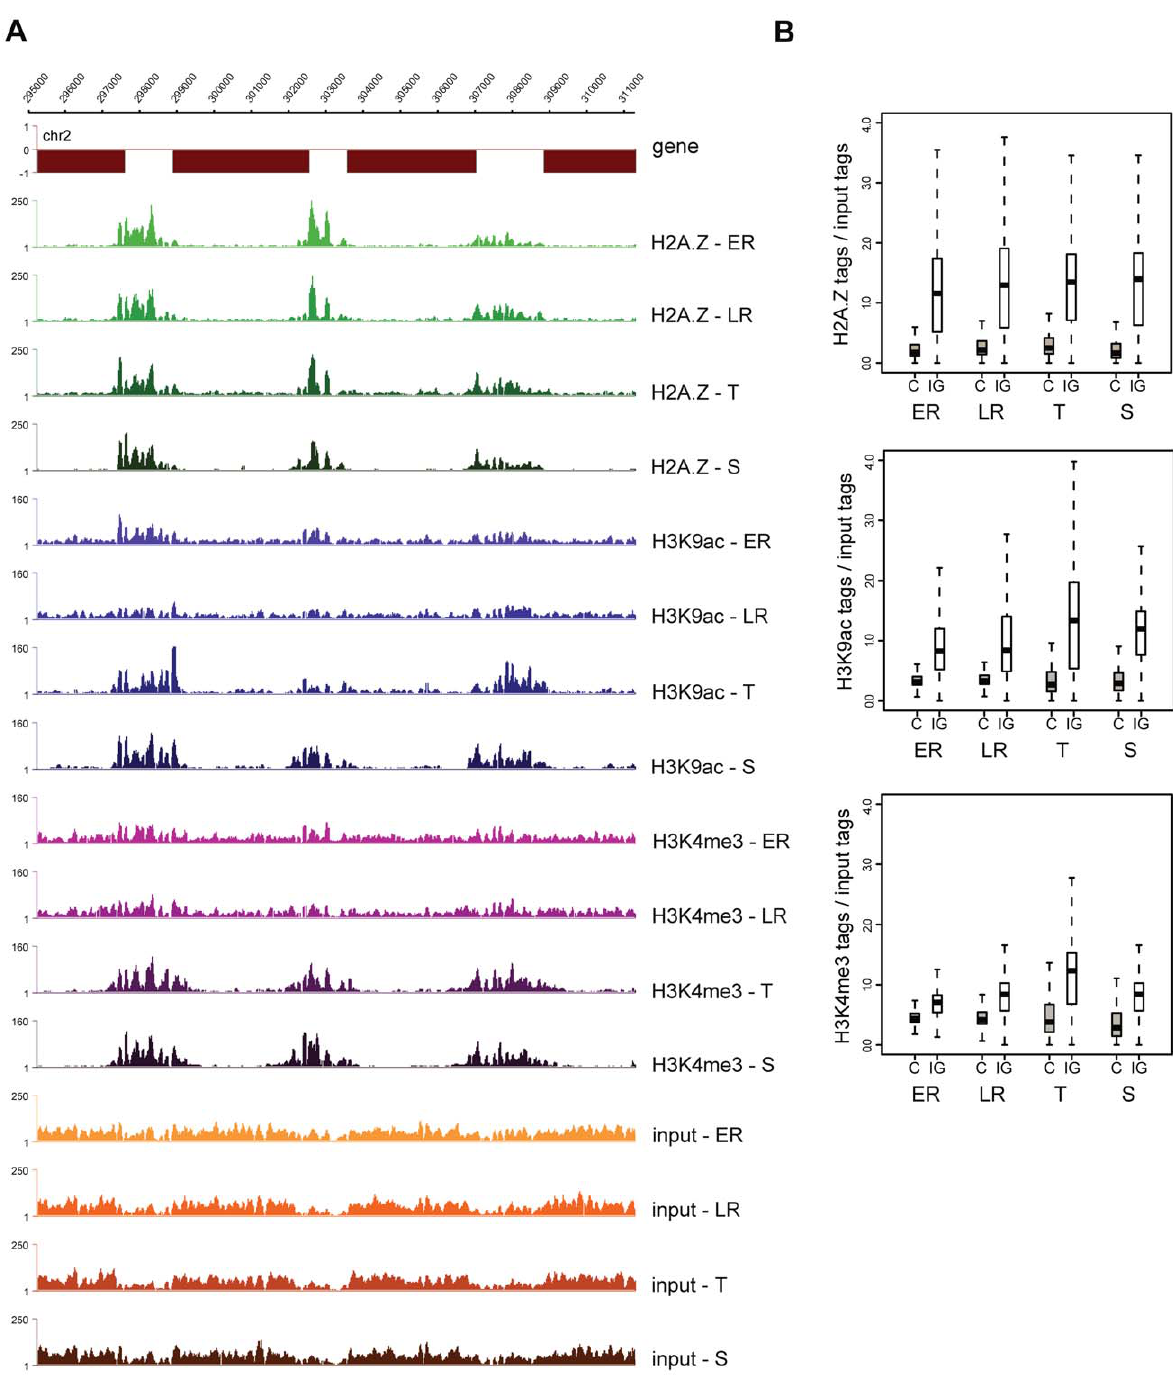
Visual inspection of the ChIP-seq profiles revealed two exceptions where dynamic H3 marking occurred independent of stable H2A.Z marking. In the coding body of over 100 genes, local increase in H3K9ac was observed specifically at the trophozoite stage (see Figure S9 for a representative example). Markedly, these